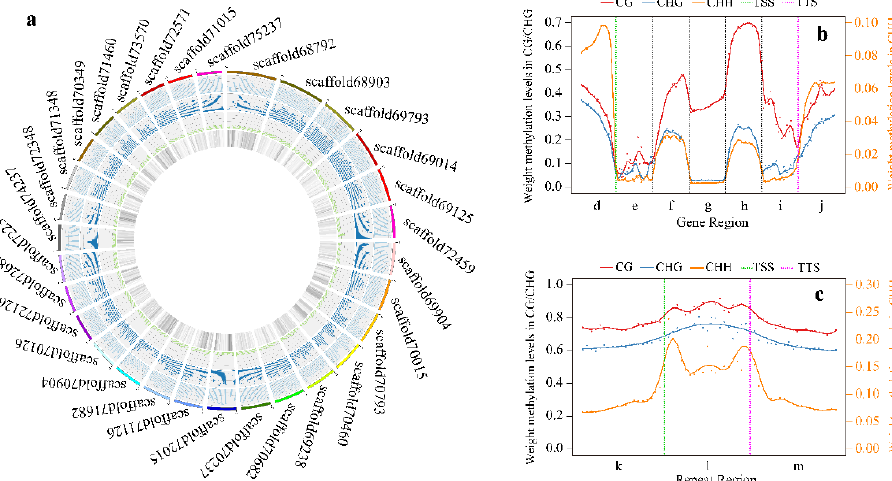
Figure 4. DNA methylation distribution in pecan genome. ( a ) Circle plot of methylation distribution in pecan chromosomes. The outermost circle refers to the chromosomes of the pecan. Light blue, blue and green bars represent the methylation levels in CG, CHG, and CHH contexts, respectively (H = A, T, or C). The innermost circle with color of gray represent the number of genes, and the darker the color is, the more genes there are. ( b ) Methylation levels in different gene regions (d: upstream; e: first exon; f: first intron; g: inner exon, h: inner intron; i: last exon; j: downstream). ( c ) Methylation levels in different repeat regions (k: upstream; l: repeat body; m: downstream). TSS: Transcription start site; TTS: Transcription termination site. The graphs were plotted based on the methylation data of SV1 pecan graft (one of the three pecan grafts with strong growth vigor). Hypermethylation CG island (CGI) regions were defined as CGI regions with methylation levels greater than 70%. We also excluded those in which the rates of C sites with coverage depth > 5× were less than 0.1, and annotated the remaining hypermethylation CGI regions. The results showed that distal intergenic regions had the highest proportions of hypermethylation CGI regions, ranging from 81.35% to 84.26% in the six pecan samples. Hypermethylation CGI regions in ≤ 1 kb promoter, 1 – 2 kb promoter and 2 – 3 kb promoter accounted for 3.03% – 4.52%, 5.74% – 6.61% and 3.65% – 4.45%, respectively. The lowest percentages of hypermethylation CGI were found in untranslated regions (UTRs) and exons (≤ 0.3%; Figure 5).